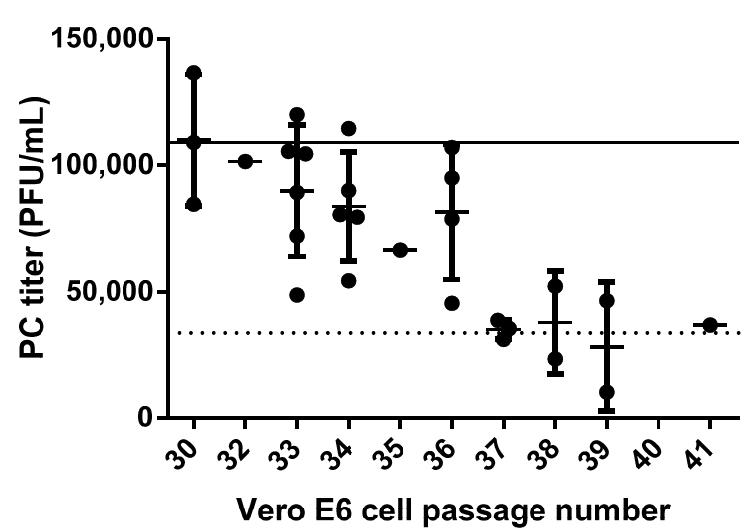
Figure 8. Positive control data collected on Vero E6 cells of various passage ages. Twenty eight measurements of the EBOV Positive Control (PC) collected over pre-, post- and on-validation studies were performed on cell passages ranging from 30 to 41 (filled circles). Averages and standard deviations are presented for multiple results on the same passage. The solid line depicts the nominal PC target titer of 1.09 × 10 5 PFU/mL, and the dotted line denotes the lower PC cutoff limit of 34,469 PFU/mL, below which the assay fails and a repeat is required.